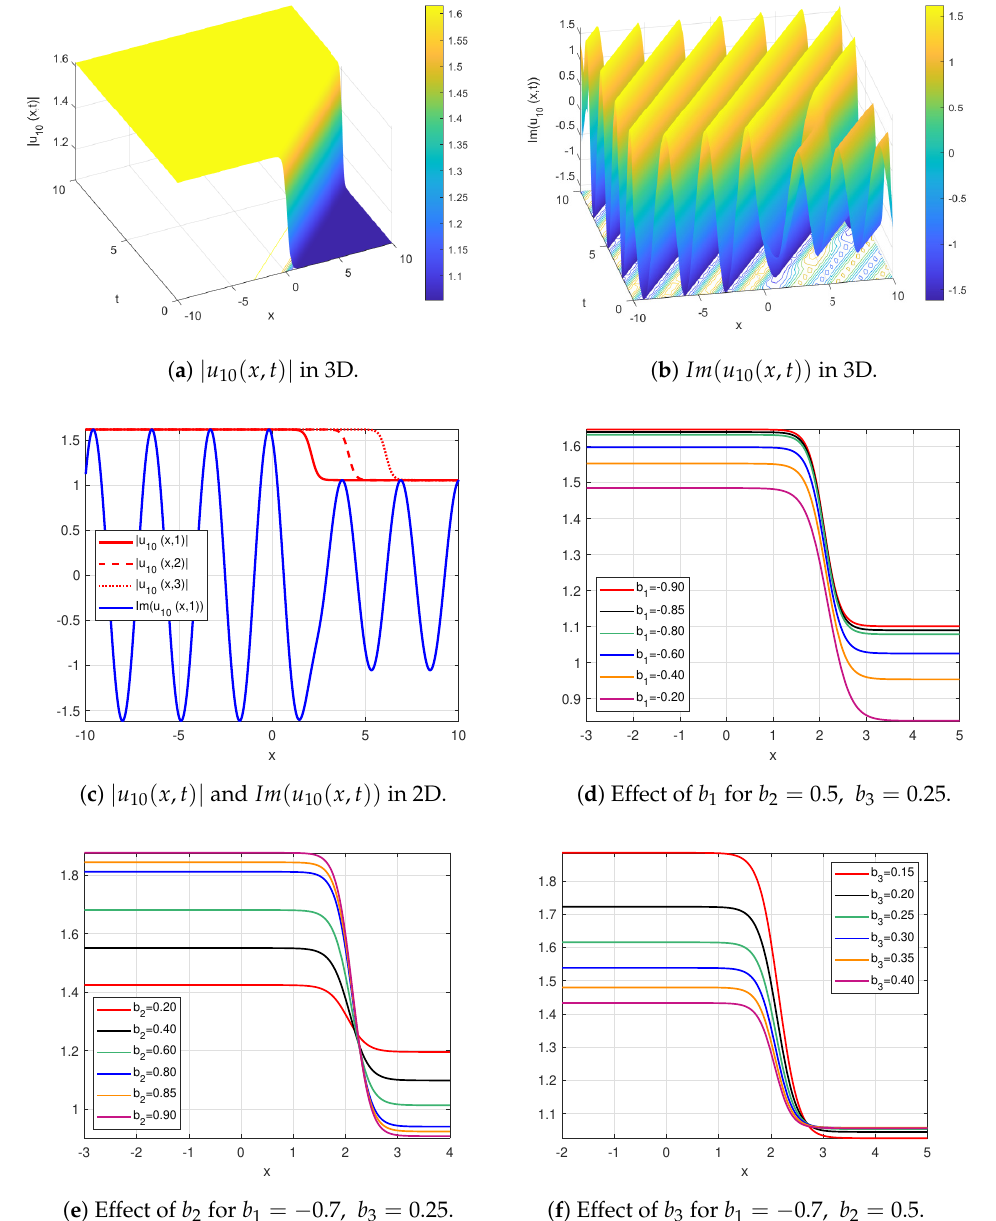
Figure 7. The various silhouettes of u 10 ( x , t ) in Equation (28) by combination of the Set 7 in Equa- tion (18) and the selected h = 0.04, a = − 0.5, φ 0 = 0.5, b 1 = − 0.7, b 2 = 0.5, b 3 = 0.25, κ = 2